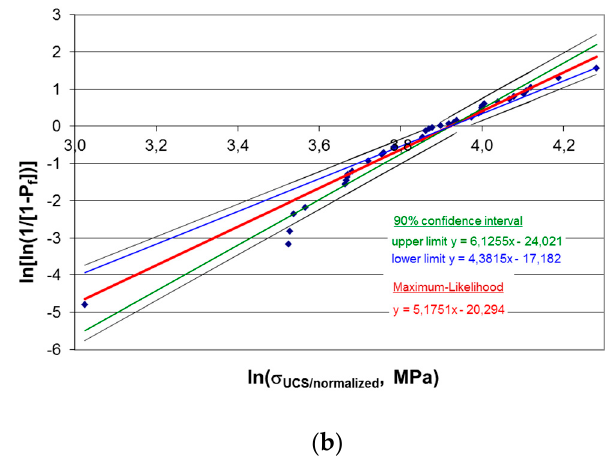
Figure 16. Compression test results—Weibull evaluation of ultimate compressive strength for AlSi7 foam with ( a ) and without TiB2 grain refiner ( b ), as-received TiH 2 as foaming agent.